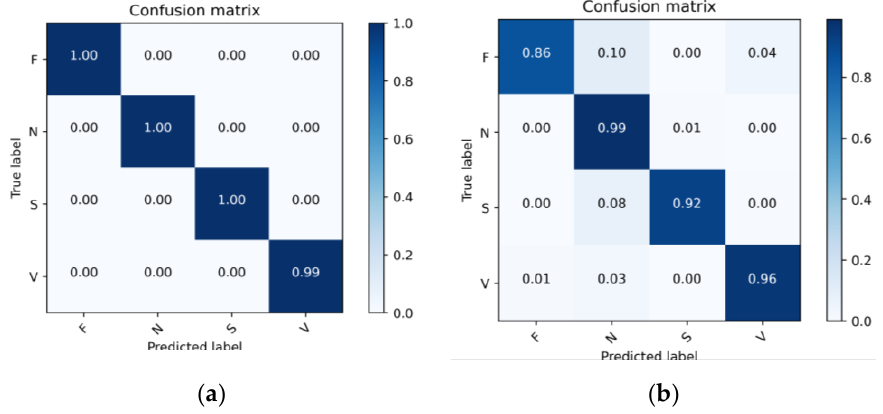
Figure 6. Confusion matrix of the CNN-GRU model. ( a ) Training-based confusion matrix. ( b ) Test-